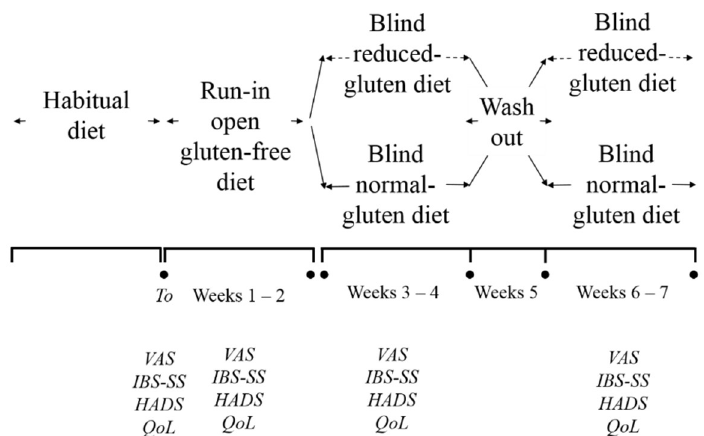
Figure 1. Crossover design of the study and the timing of clinical evaluations. IBS-SS, Irritable Bowel Syndrome Severity Score; VAS, Visual Analogue Scale; HADS, Hospital Anxiety and Depression Scale; QoL, Quality of Life.